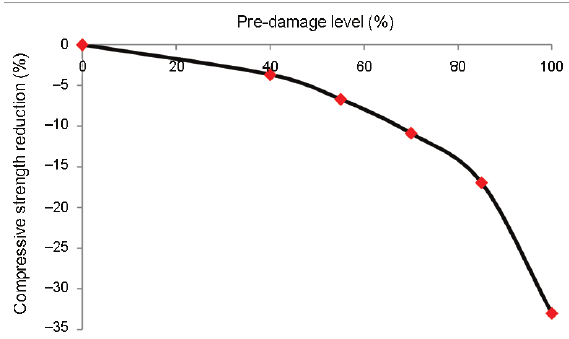
Fig. 6. Compressive strength reduction of pre-damaged specimens confined with CFRP